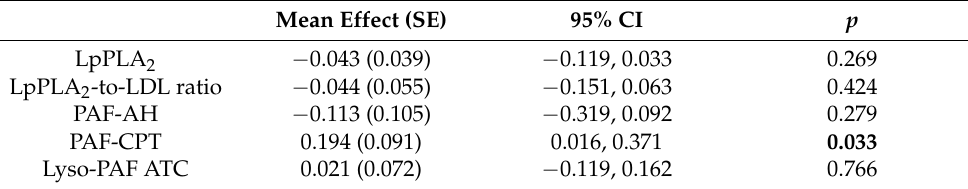
Table 4. Effect of the enriched fish (EF) versus the conventional fish (CF) diet on the activity of PAF metabolic enzymes (treatment